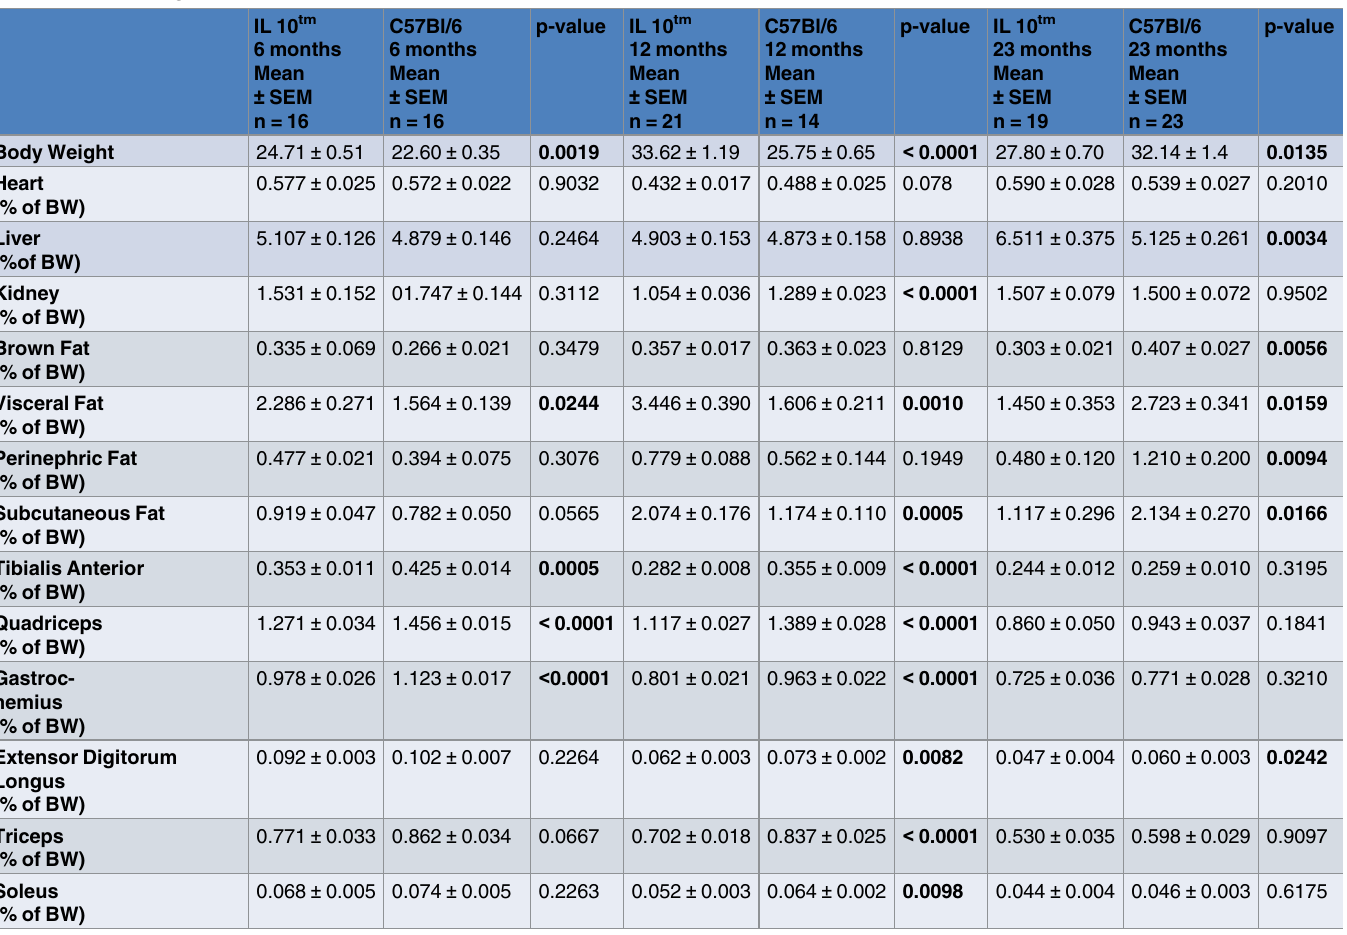
Upon sacrifice each mouse was carefully dissected and tissues weighed for an in depth assess- ment of body composition (Table 2). Significant differences between strains at young age include increased body weight (p = 0.002) and percent visceral fat (p = 0.024), and decreased percent tibialis anterior (p = 0.0005), quadriceps (p < 0.0001) and gastrocnemius (p < 0.0001) in IL 10 tm mice. At middle age, body weight (p < 0.0001), percent visceral fat (p = 0.0010) and percent subcutaneous fat (p = 0.0005) were increased in IL 10 tm mice while percent kidney (p < 0.0001), percent tibialis anterior (p < 0.0001), percent quadriceps (p < 0.0001), percent gastrocnemius (p < 0.0001), percent extensor digitorum longus (p = 0.008), percent triceps (p < 0.0001), and percent soleus (p = 0.0098) were decreased. Changes in the old group in- cluded decreased body weight (p = 0.014), percent brown fat (p = 0.006), percent visceral fat (p = 0.016), percent perinephric fat (p = 0.009), percent subcutaneous fat (p = 0.017) and Table 2. Tissue weights at the time of